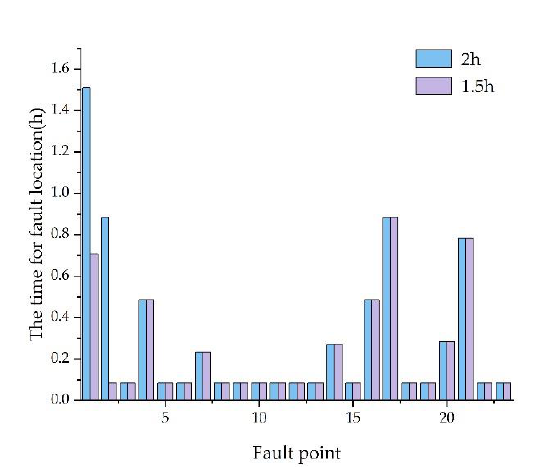
ff erent outage time.